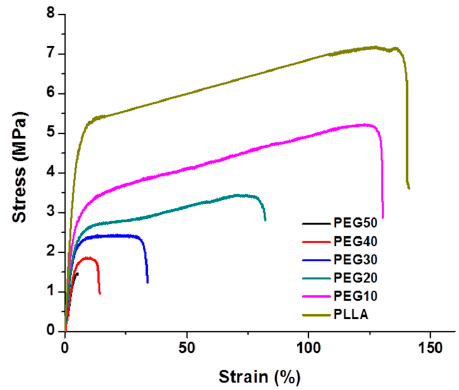
Figure 2. Stress-strain curves of electrospun PLLA/PEG scaffolds with various PEG fractions. 2.2. Isolation and Characterizations of Human Amniotic Mesenchymal Cells (hAMSCs)